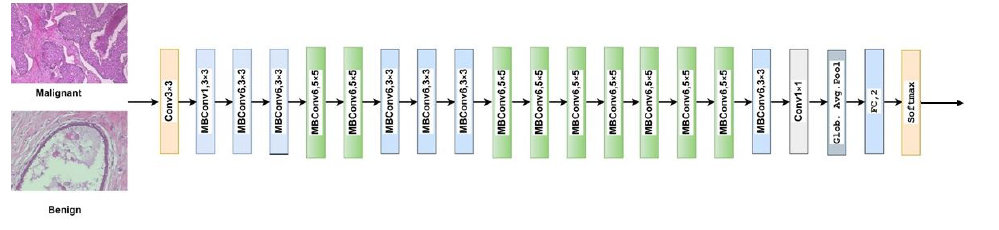
Figure 6. EfficientNetB0